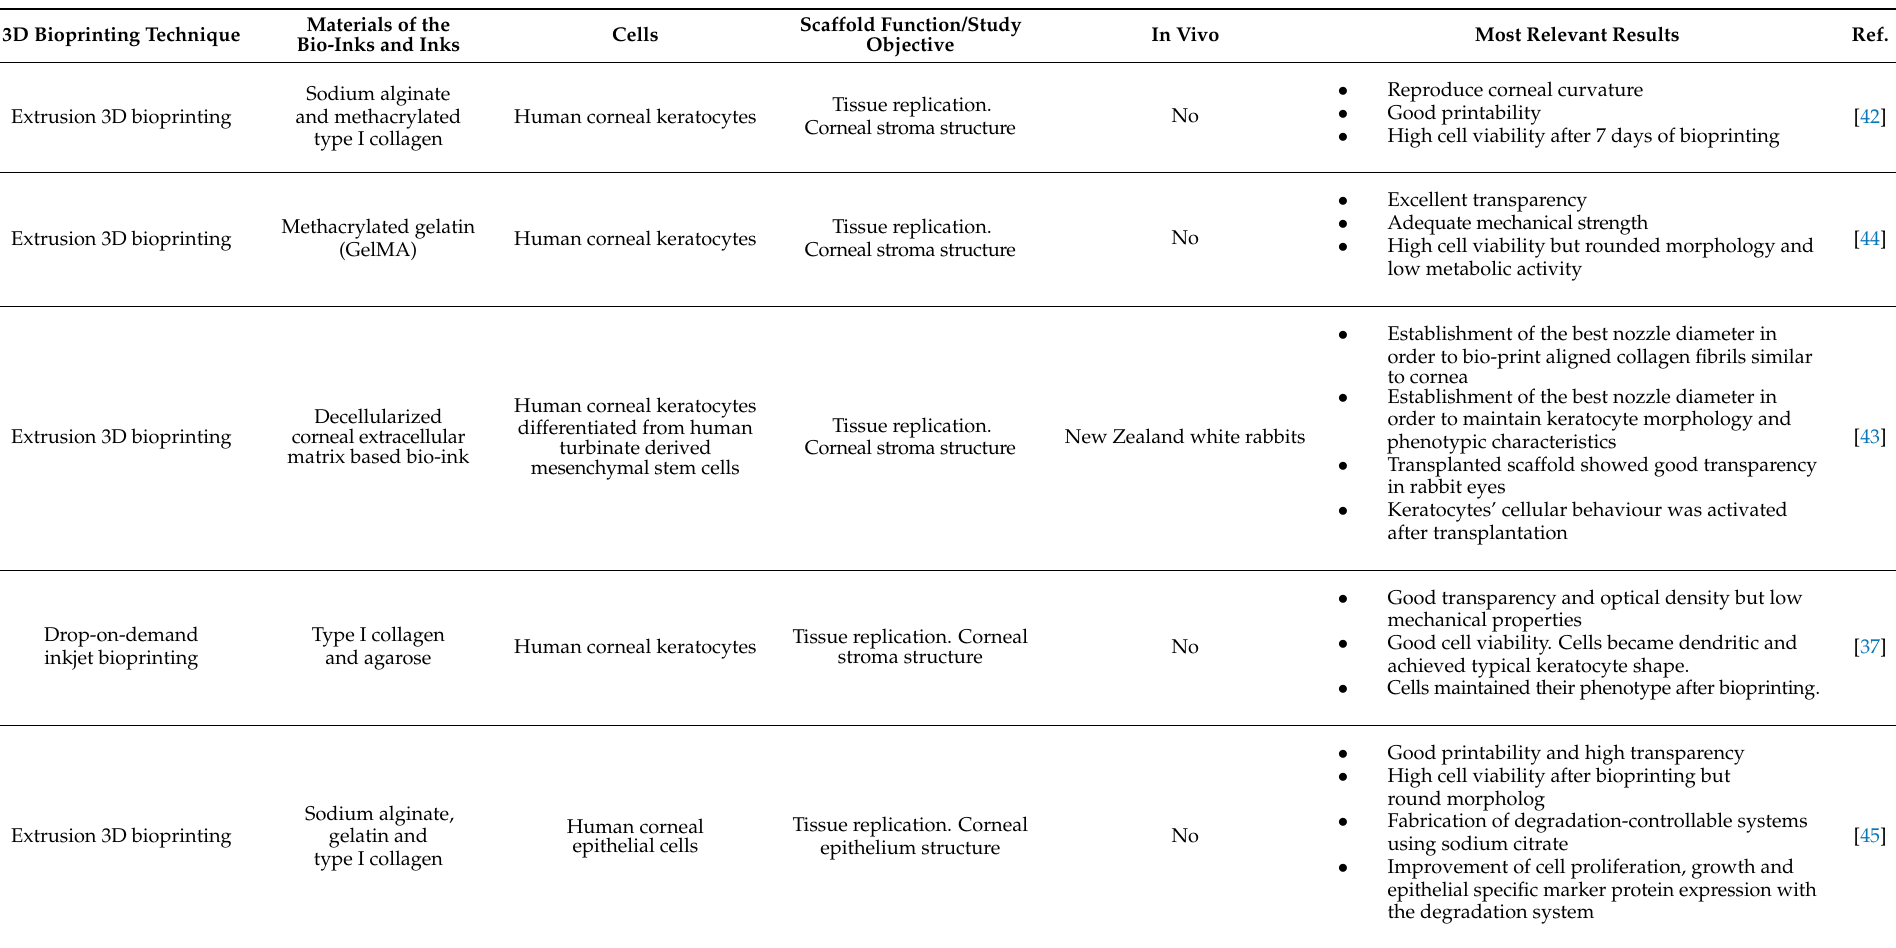
Table 1. Current studies of 3D bioprinting for cornea tissue